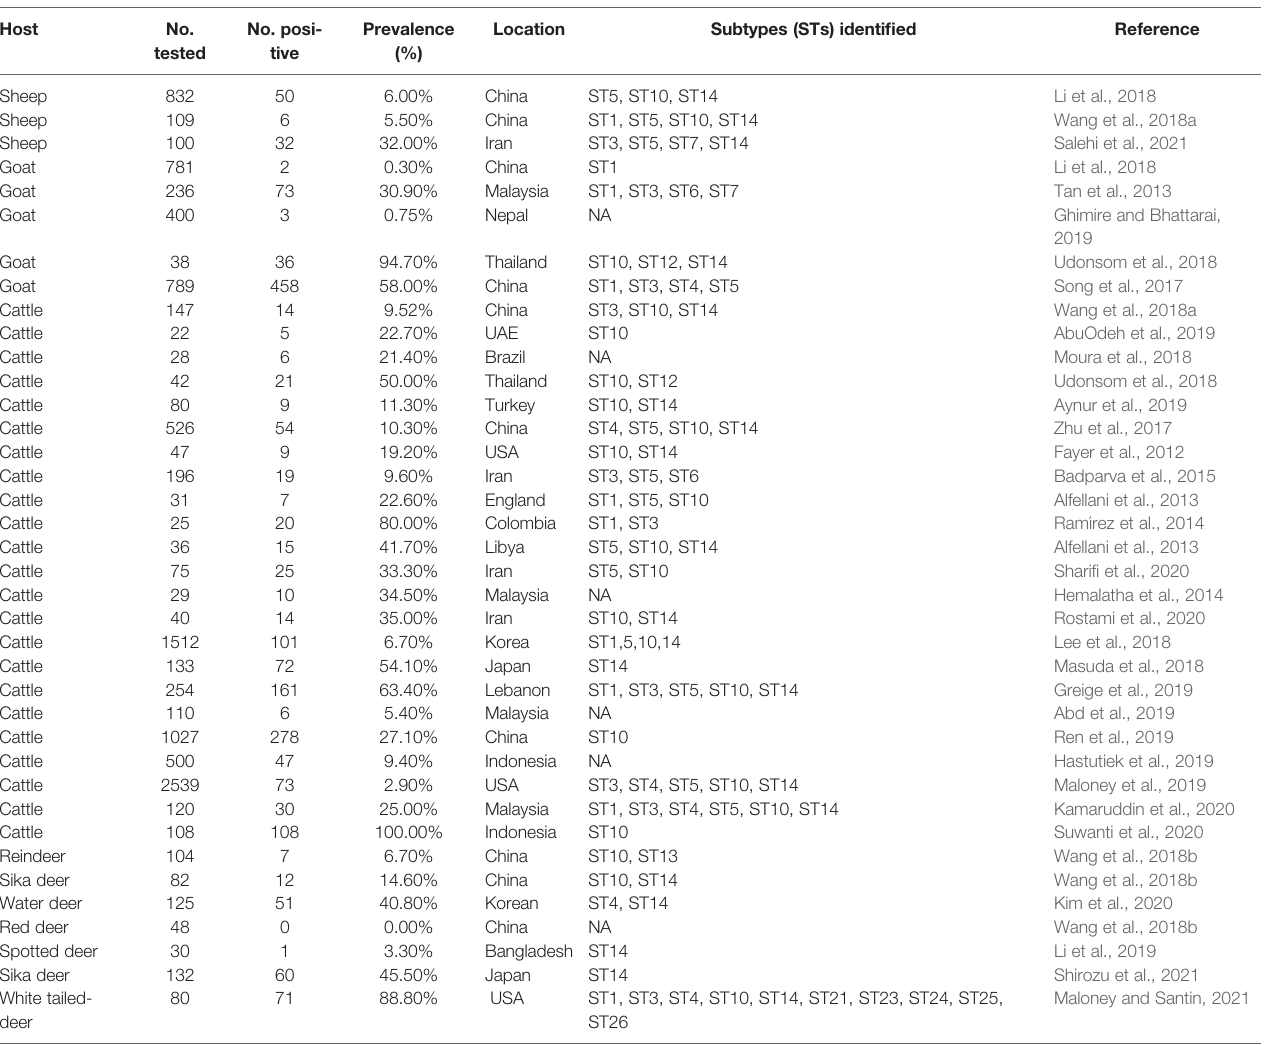
TABLE 1 | Subtypes and prevalence of Blastocystis sp. detected from the ruminants worldwide (2010 – 2021). Host No.